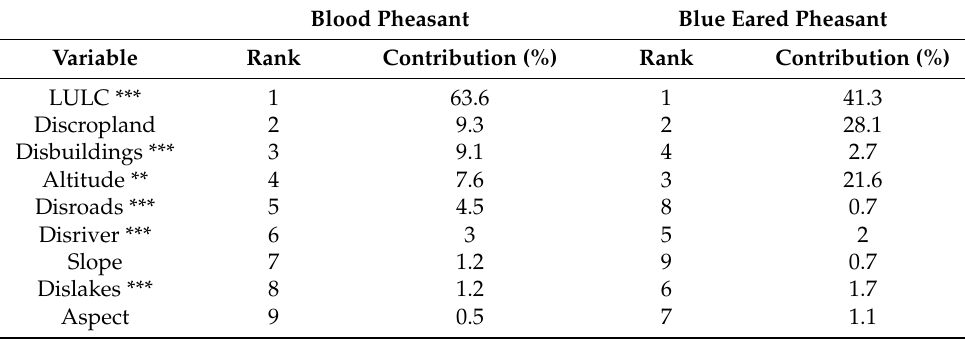
Table 2. Percent contribution for each variable and differentiation test for each pair of variables. Variables were ranked by contribution percentage to the